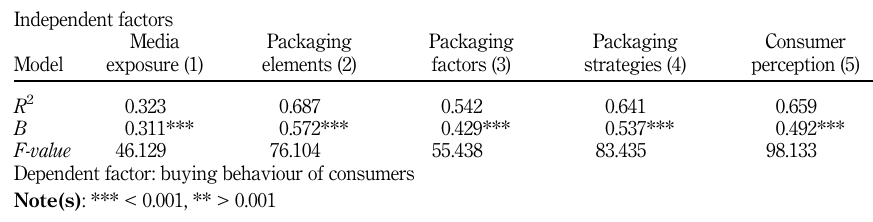
Table 13. Summary results of multiple